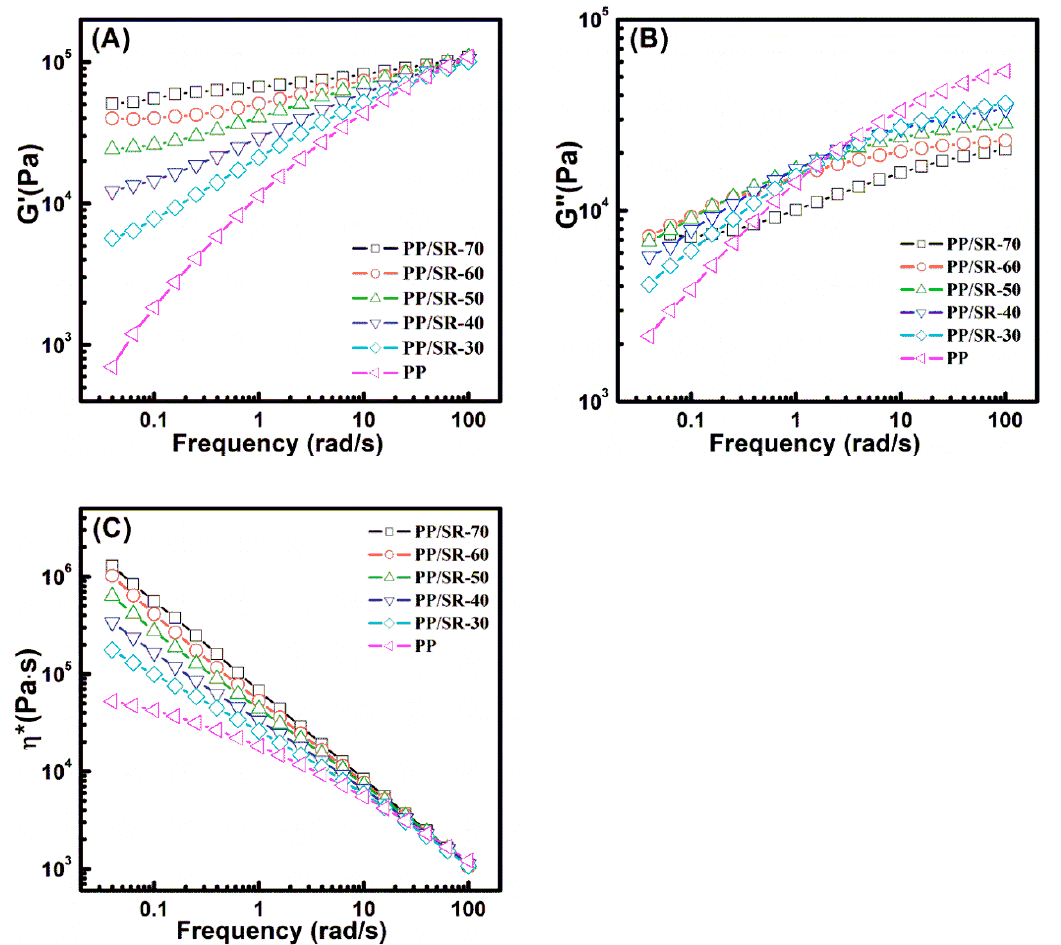
Figure 5. Plots of ( A ) G ’, ( B ) G ” and ( C ) complex viscosity ( η *) vs. frequency for polypropylene (PP)